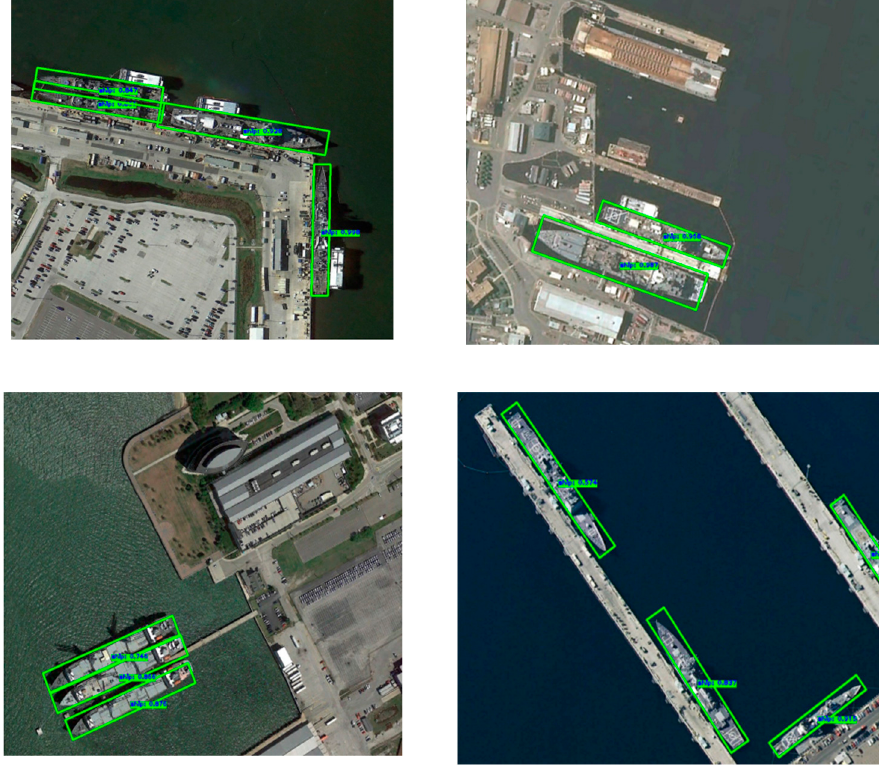
Figure 3. Multimodal data fusion results of the proposed method on the HRSC 2016 dataset.